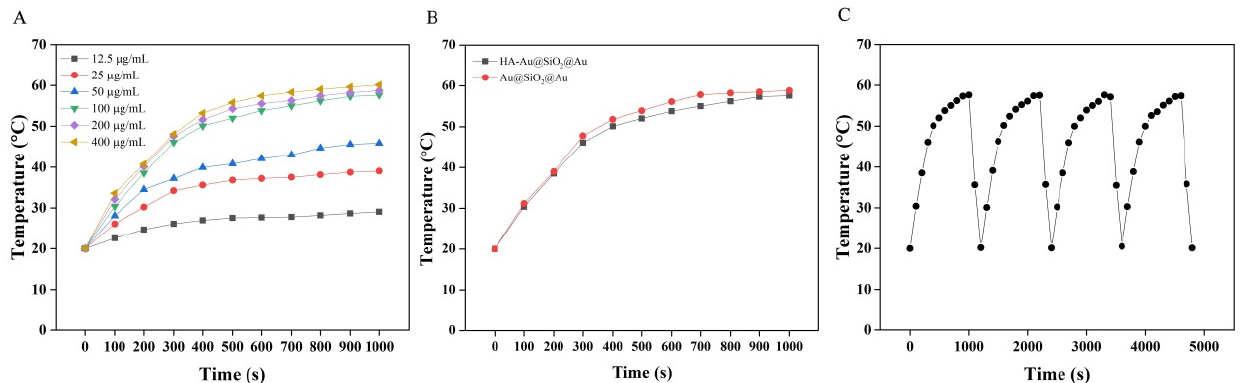
Figure 2. Photothermal effect of Au@SiO 2 @Au and HA-Au@SiO 2 @Au. ( A ) Temperature curves of HA-Au@SiO 2 @Au at different NP concentrations (12.5, 25, 50, 100, 200, and 400 μ g·mL − 1 ) irradiated by NIR laser (808 nm, 1.5 W·cm − 2 ). ( B ) Temperature curves of Au@SiO 2 @Au and HA-Au@SiO 2 @Au at NP concentration of 100 μ g·mL − 1 irradiated by NIR laser (808 nm, 1.5 W·cm − 2 ). ( C ) Cyclic stability test of HA-Au@SiO 2 @Au at NP concentration of 100 μ g·mL − 1 irradiated by NIR laser (808 nm, 1.5 W·cm − 2 ).